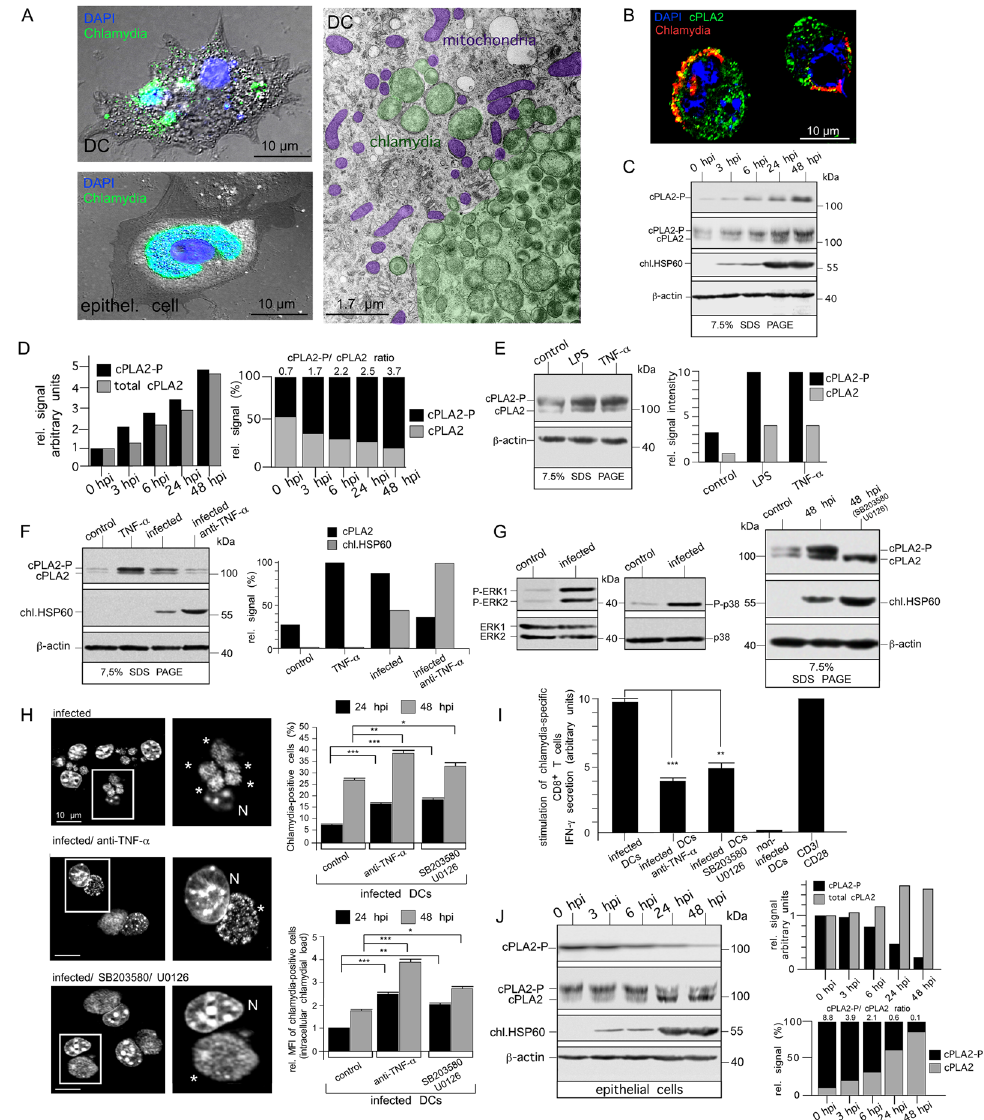
Figure 2. Chlamydial infection of DCs is accompanied by induced expression and activation of AA-producing cPLA2. ( A ) Immunofluorescence of infected DCs (JAWSII) and epithelial cells (MN-R) (48 hpi) (left) stained for chlamydial LPS (green) overlaid on phase-contrast images. Host DNA and intracellular chlamydiae are visualised with DAPI (blue). Electron micrographs of infected DCs (right). Chlamydiae and mitochondria are artificially coloured. ( B ) Immunofluorescence of infected DCs costained for cPLA2 (green) and chlamydial LPS (red) (blue, DAPI). ( C , D ) Western blot of DCs infected for 0, 3, 6, 24, or 48 h using antibodies against phospho-cPLA2 (cPLA2-P), total cPLA2, chl.HSP60, and β -actin ( C ). cPLA2-P migrates more slowly on 7.5% SDS-gels than cPLA2. cPLA2 levels and cPLA2-P:cPLA2 ratios were determined by densitometric scanning ( D ). ( E ) Western blot of DCs treated with LPS (10 µ g/ml) or TNF- α (30 ng/ml) for 48 h using antibodies against cPLA2 and β -actin. cPLA2-P and cPLA2 levels were determined by densitometric scanning ( D ). ( F ) Western blot of infected DCs treated with TNF- α -neutralizing antibodies using cPLA2, chl.HSP60, and β -actin-specific reagents (left). Quantification by densitometric scanning (right). ( G ) Western blot of infected DCs (12 hpi) using antibodies against phospho-ERK1/2 (P-ERK1/2), total ERK1/2, phospho-p38 (P-p38), and total p38 (left). Western blot of infected DCs treated with ERK1/2 (U0126)- and p38 (SB203580)-specific inhibitors using antibodies against cPLA2, chl.HSP60, and β -actin (right). ( H ) Microscopy of DAPI-stained infected DCs treated with TNF- α -neutralizing antibodies or MAPK inhibitors. Inclusions and disintegrated chlamydial structures are indicated by asterisks (left). Flow cytometry of such treated cells using the IMAGEN kit. Data from three independent experiments (24 and 48 hpi) are summarised in bar graphs as in Fig. 1F (right). ( I ) IFN- γ secretion by chlamydia-specific CD8 + T cells stimulated with infected DCs treated with anti-TNF- α or MAPK inhibitors. Results are depicted as in Fig. 1G. ( J ) Western blot of epithelial cells infected for 0, 3, 6, 24, or 48 h using antibodies against cPLA2-P, total cPLA2, chl.HSP60, and β -actin (left). cPLA2 levels and cPLA2-P:cPLA2 ratios were determined by densitometric scanning (right). Statistical analysis in ( H and I ) was performed as described in Methods ( * p < 0.05; ** p < 0.01; *** p < 0.001 versus controls; n =